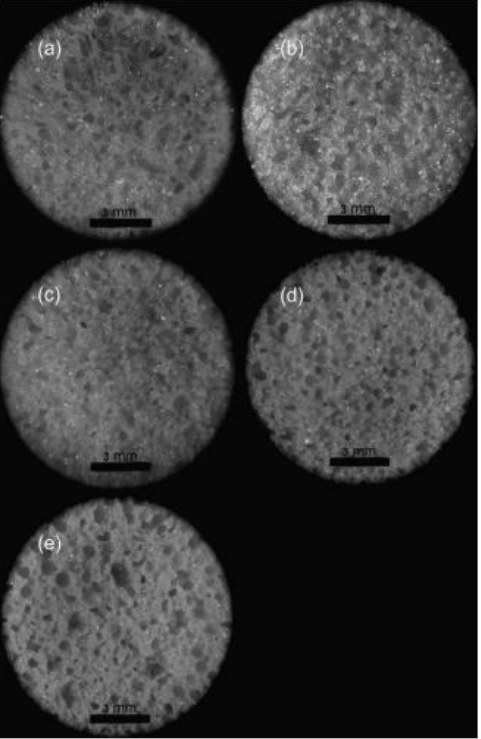
Figure 14. Optical microscope images (with 5 times magnification) of benzoxazine foam at varying densities of ( a ) 407 kg/m 3 , ( b ) 378 kg/m 3 , ( c ) 339 kg/m 3 , ( d ) 306 kg/m 3 , and ( e ) 273 kg/m 3. (reproduced from the work in [59] with permission.)